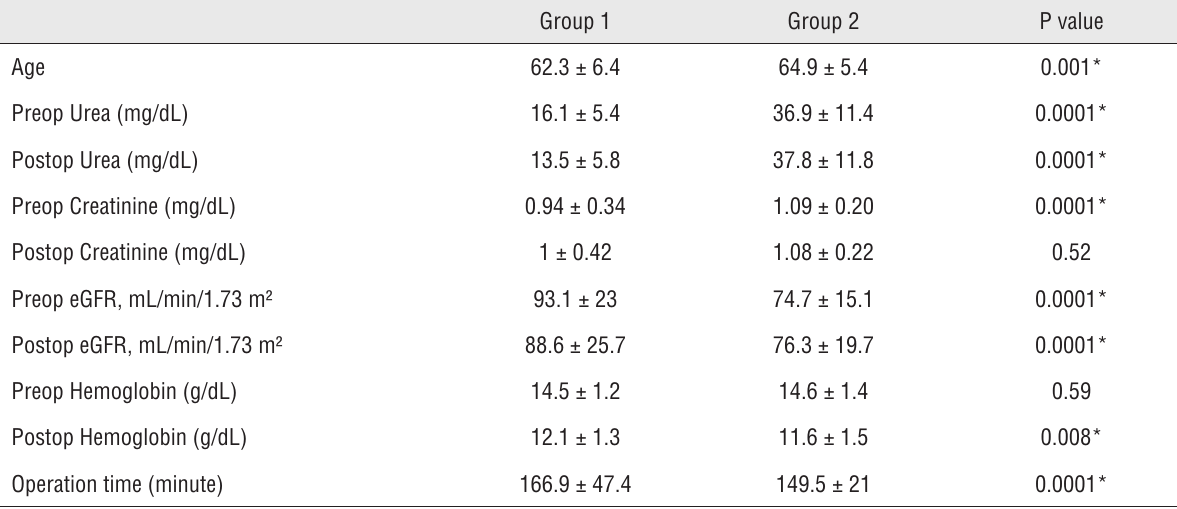
Table 1 - Age, preoperative and postoperative data between the RALP and RRP patients.